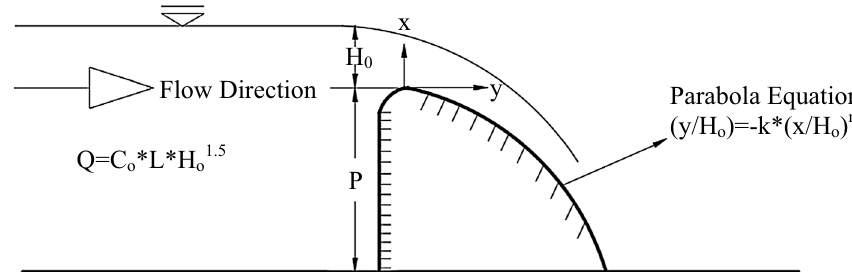
Fig. 1 General view of ogee spillway